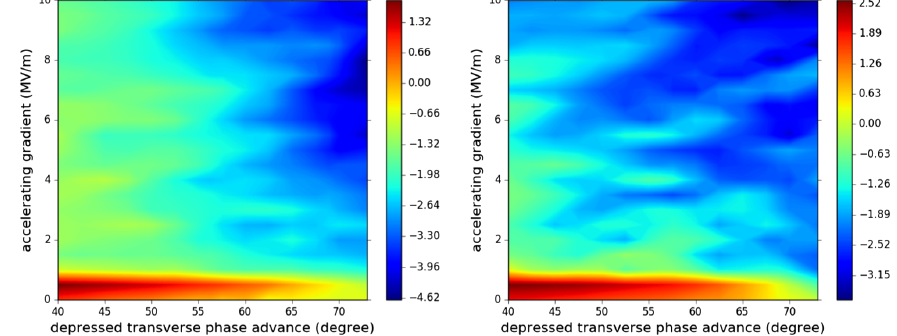
FIG. 5. The final log horizontal emittance growth (left) and longitudinal emittance growth (right) at the end of 100 lattice periods as a function of accelerating gradient and depressed transverse phase advance in the solenoid-rf channel.